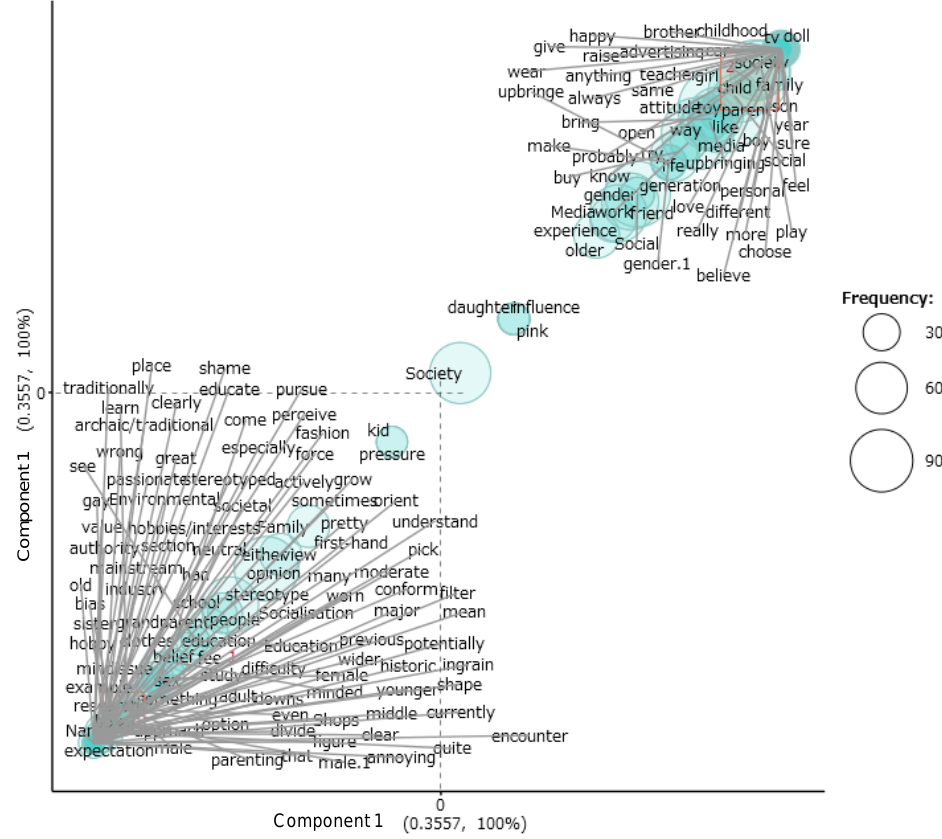
Figure 3. Results of correspondence analysis of frequently used words by